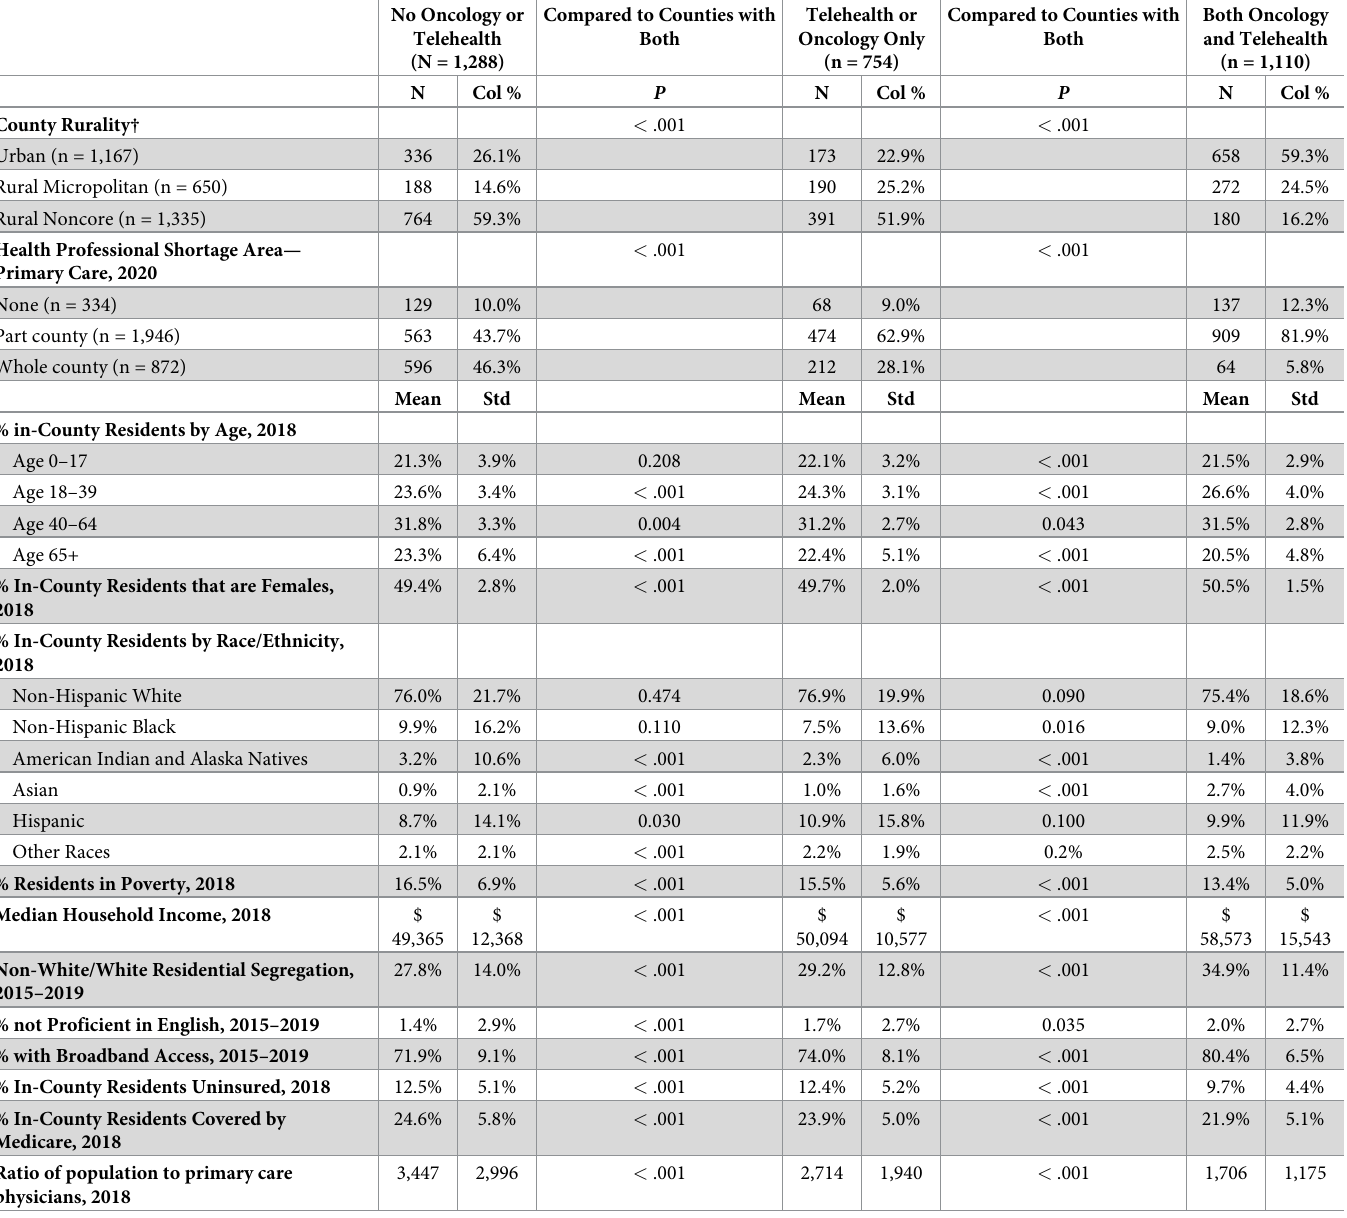
Table 2. County characteristics by telehealth and oncology services provision status,